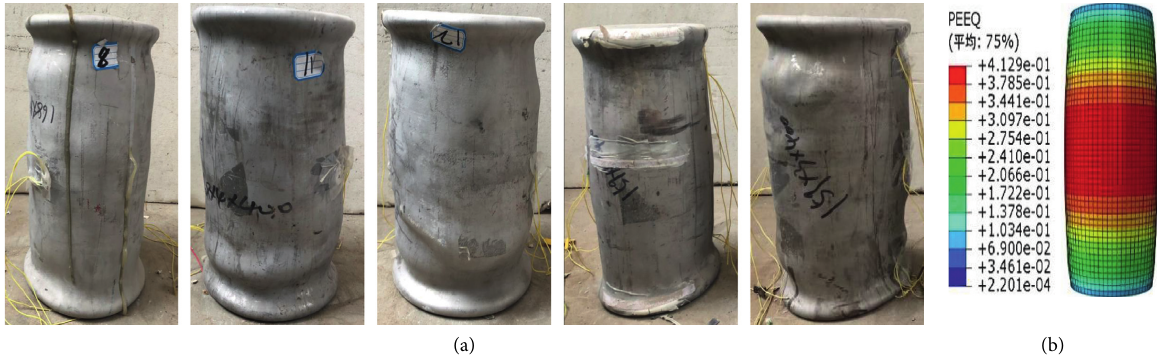
Figure 4: Failure mode of the specimen. (a) Experimental result and (b) FE result.